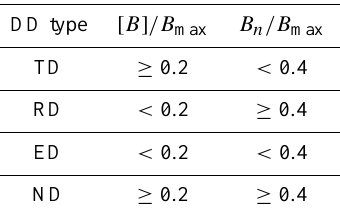
Fig. 7. Distribution of DD (cid:5) per day normalized on 1AU with a bin size of 5 ◦ and average v ( (cid:5) ) over θ ; top: TS, bottom; B criterion. Table 3. Criteria to determine the types of the DDs (after Neuge- bauer et al., 1984) Fig. 8. Distribution of the DD phase space, for example, for the